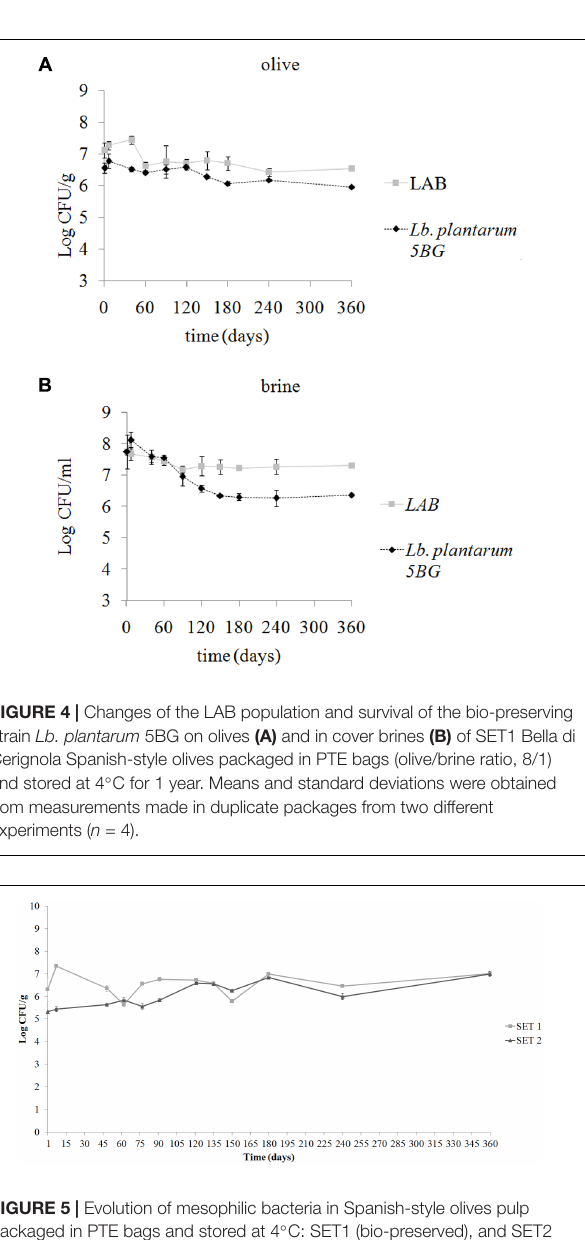
log CFU/ml). Molds, staphylococci, and Enterobacteriaceae were